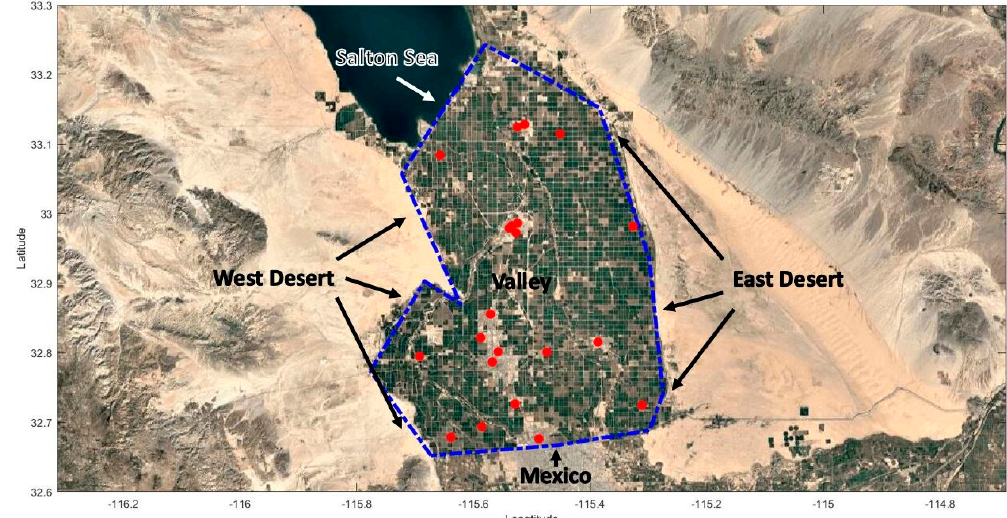
Figure 3. Locations of sources (blue dashed lines) and IVAN air monitors (red dots) used in dispersion modeling.